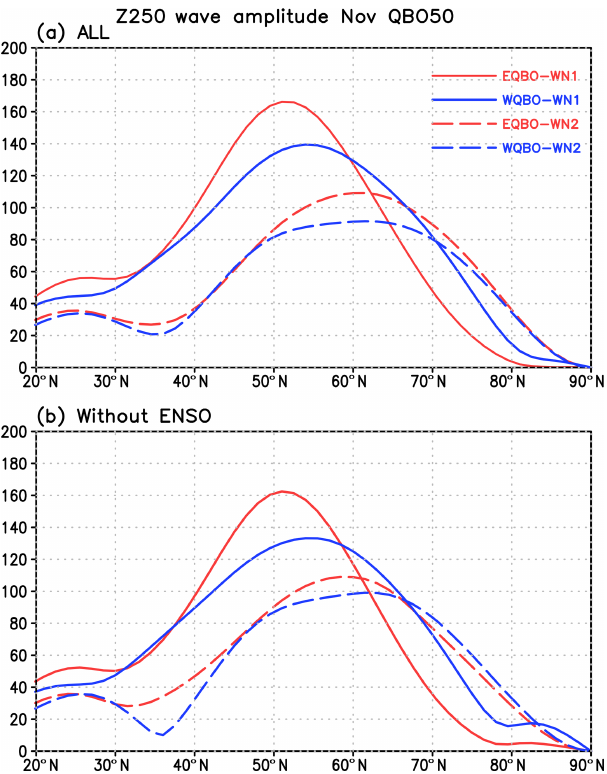
Figure 9. Wave amplitudes at 250hPa as a function of latitude in the different QBO phases for November. The solid red (blue) line de- notes wavenumber 1 in the EQBO (WQBO) composite. Red (blue) dashed line denotes wavenumber 2 in the EQBO (WQBO) com- posite. The y axis denotes amplitude in meters. (a) All composite. (b) Composite without ENSO winters.